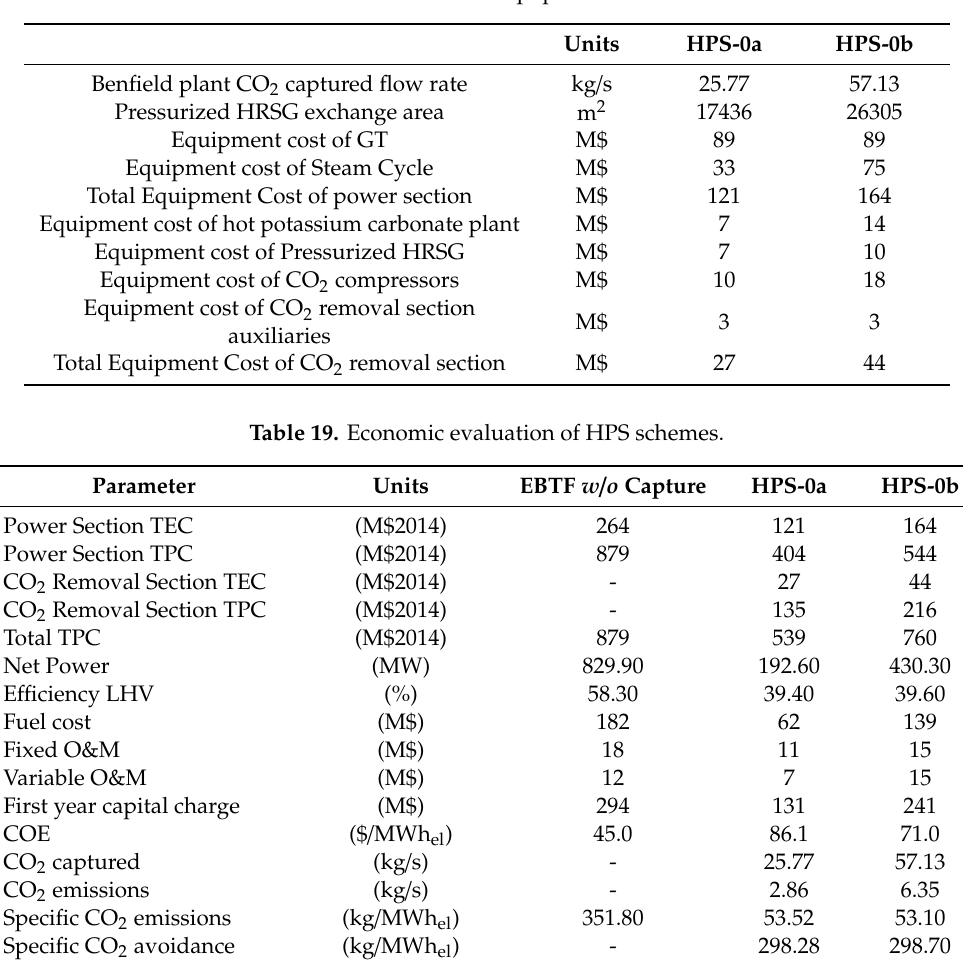
Table 18. HPS main results of equipment cost assessment.